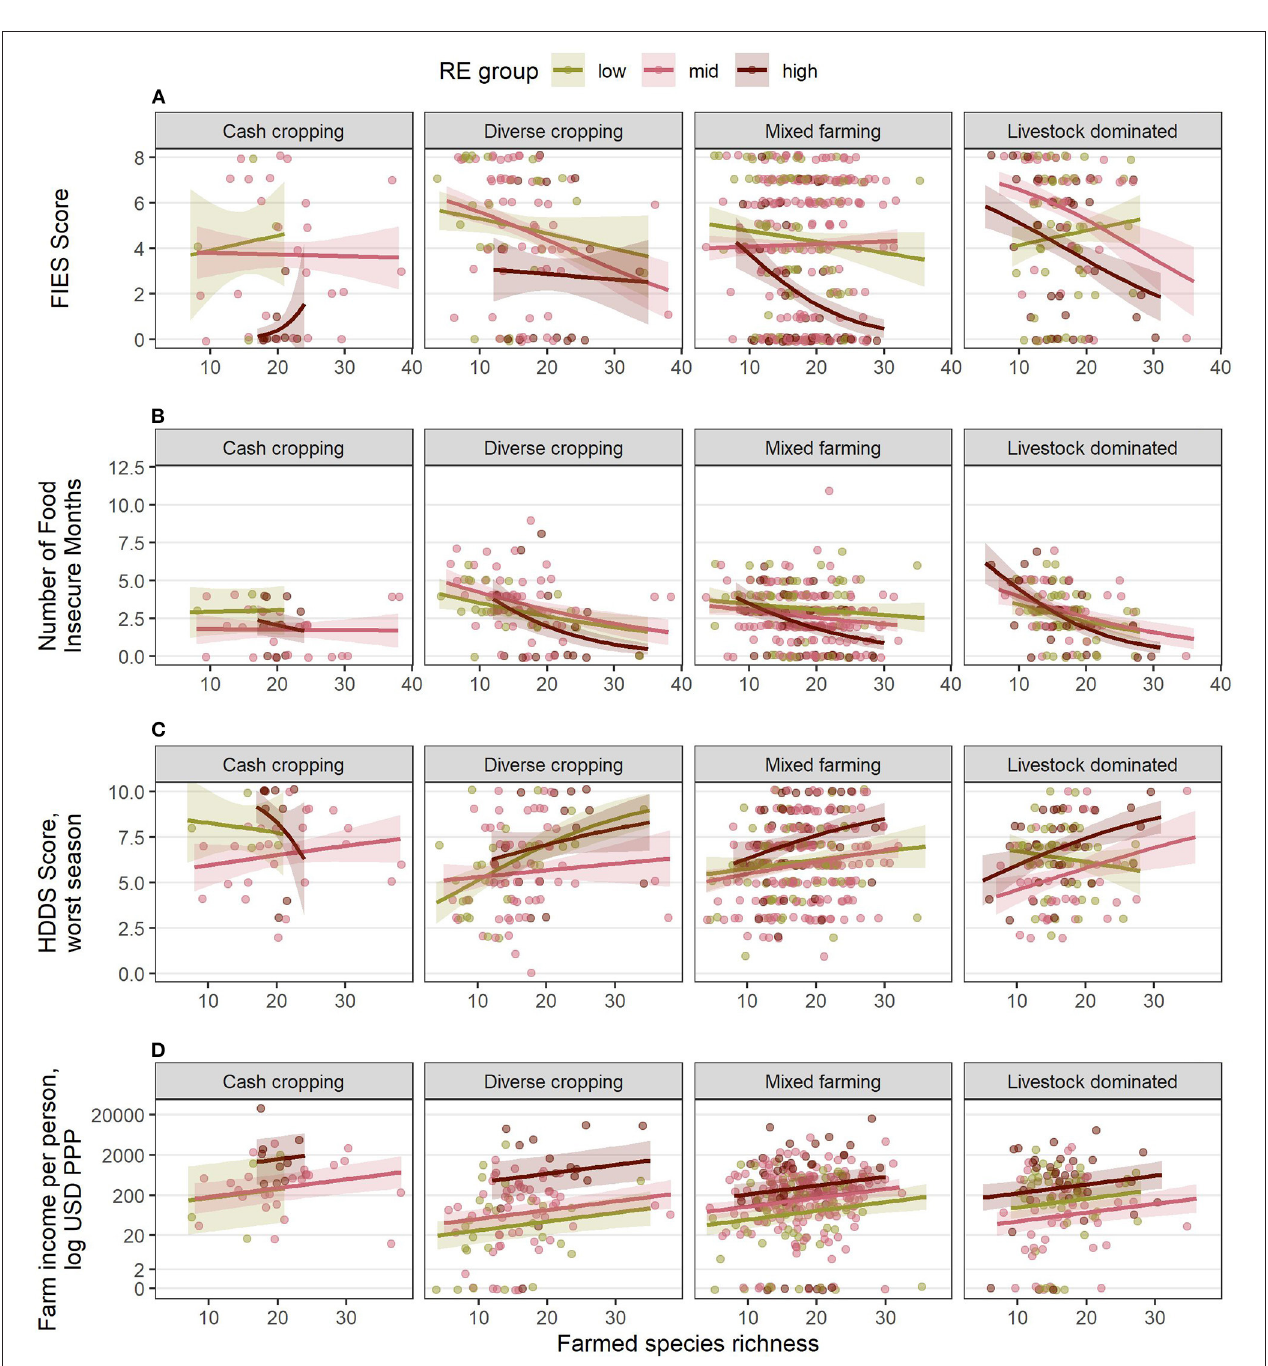
FIGURE 7 | Estimated relationships between livelihood outcomes in Kenya and the combinations of RE groups, FC groups and species richness (SR) derived from the final, reduced models for (A) FIES score, (B) number of food insecure months, (C) HDDS in the worst season, and (D) farm income per person, USD PPP. Lines indicate the estimated mean response, while shaded ribbons indicate 95% confidence intervals for the mean response. Graphs include extrapolation of the estimated relationships beyond the observed ranges of farmed species richness, to enable comparison of the shapes of the responses for different combinations of RE and FC groups, but extrapolated estimates should be interpreted with caution. Estimated responses for (A–C) are back-transformed from the logit scale on which the models were fitted. Estimated responses for (D) are shown on the log-transformed scale used for analysis (although axis labels show values on the linear scale). Points show individual (raw) datapoints from the survey responses, jittered around the true value so points do not obscure one another.